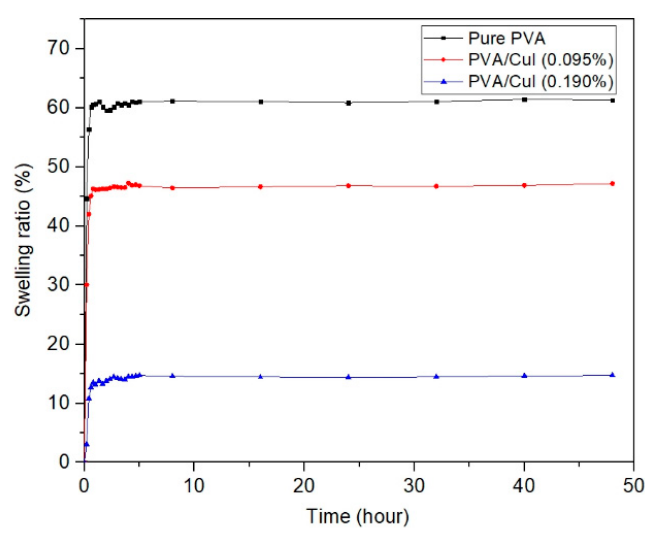
Figure 11. The swelling behavior of pure PVA, PVA/CuI (0.095%) and PVA/CuI